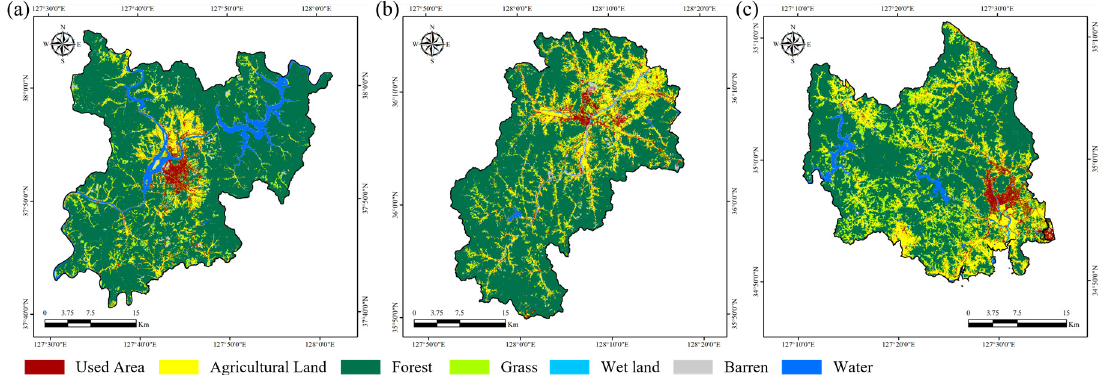
Figure 4. The deep learning—based land cover map in this study for ( a ) Chuncheon, ( b ) Gimcheon,